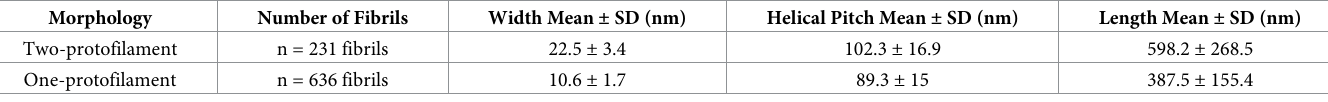
The measurements were performed using EMAN’ boxer image software.